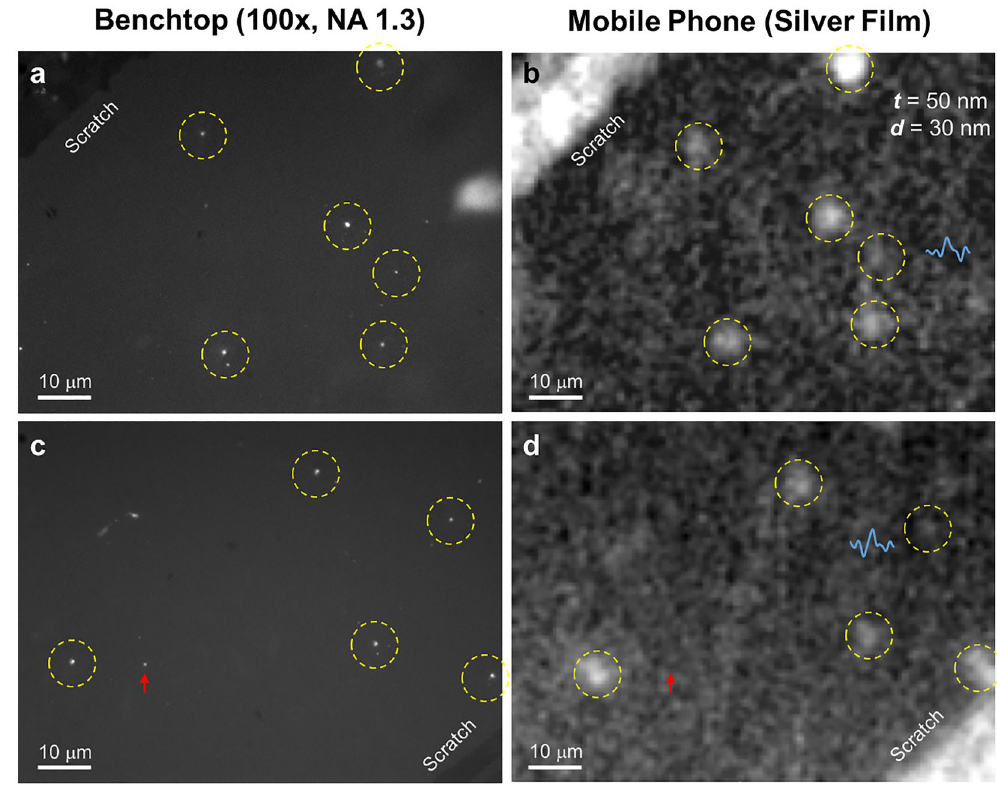
Figure 5. Imaging of single QDs with our smartphone-based SEF microscope. ( a , c ) Single QDs imaged by a conventional benchtop microscope. ( b , d ) Same regions of interest imaged by the mobile SEF microscope, where the yellow dashed circles highlight the successful detection of single QDs on the mobile phone, and the red arrow represents a missed detection. Two intensity line scans, corresponding to weaker QDs, are also shown (blue